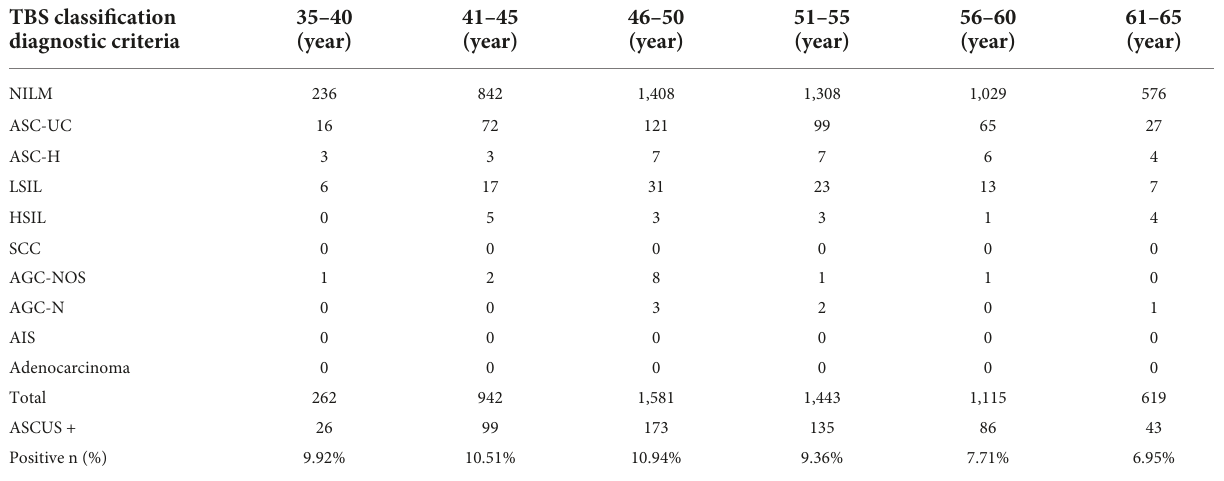
TABLE 9 Age specificity of TCT positivity.